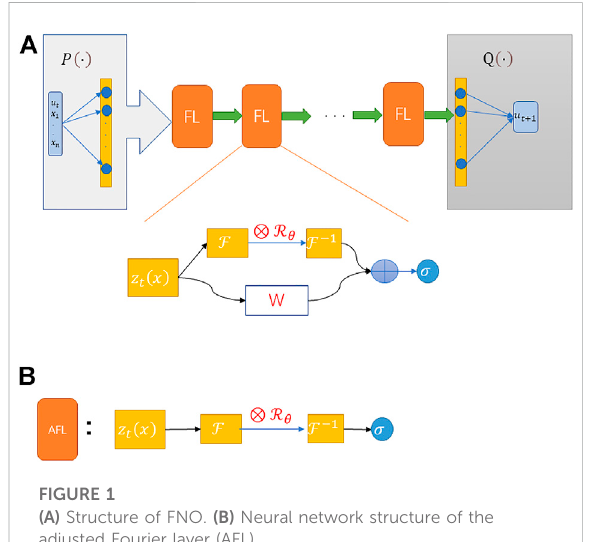
FIGURE 1 (A) Structure of FNO. (B) Neural network structure of the adjusted Fourier layer